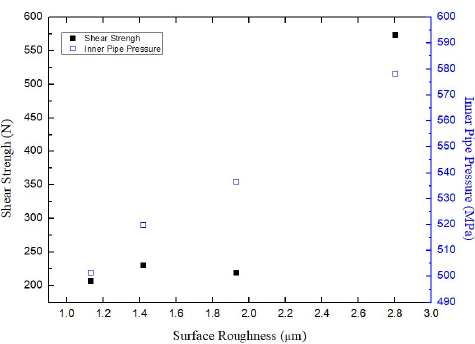
Figure 13. Inner pipe pressure result on the contact surface.